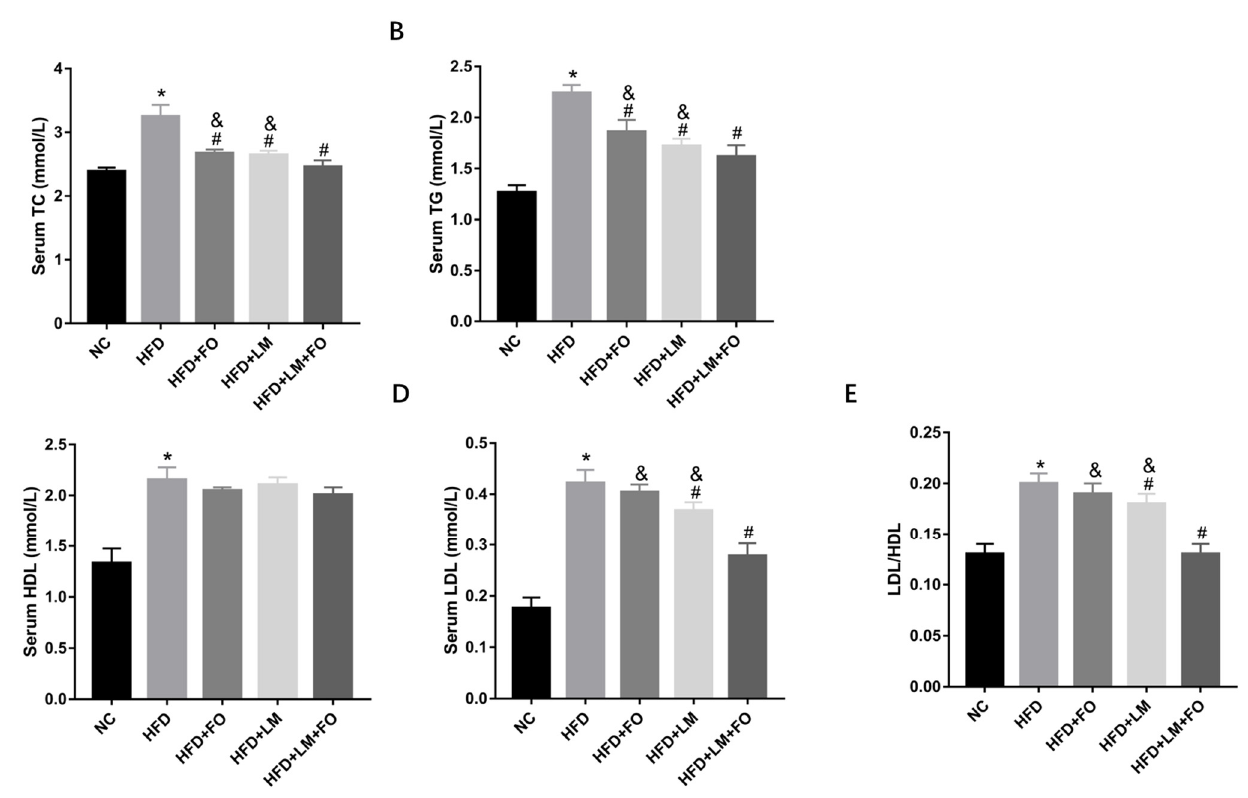
6 of 15 Figure 1. Effects of FO and LM on body weight and adipose tissue in HFD mice. Male C57BL/6J mice were randomly grouped into NC (sterile saline), HFD (sterile saline), HFD + FO (FO at 250